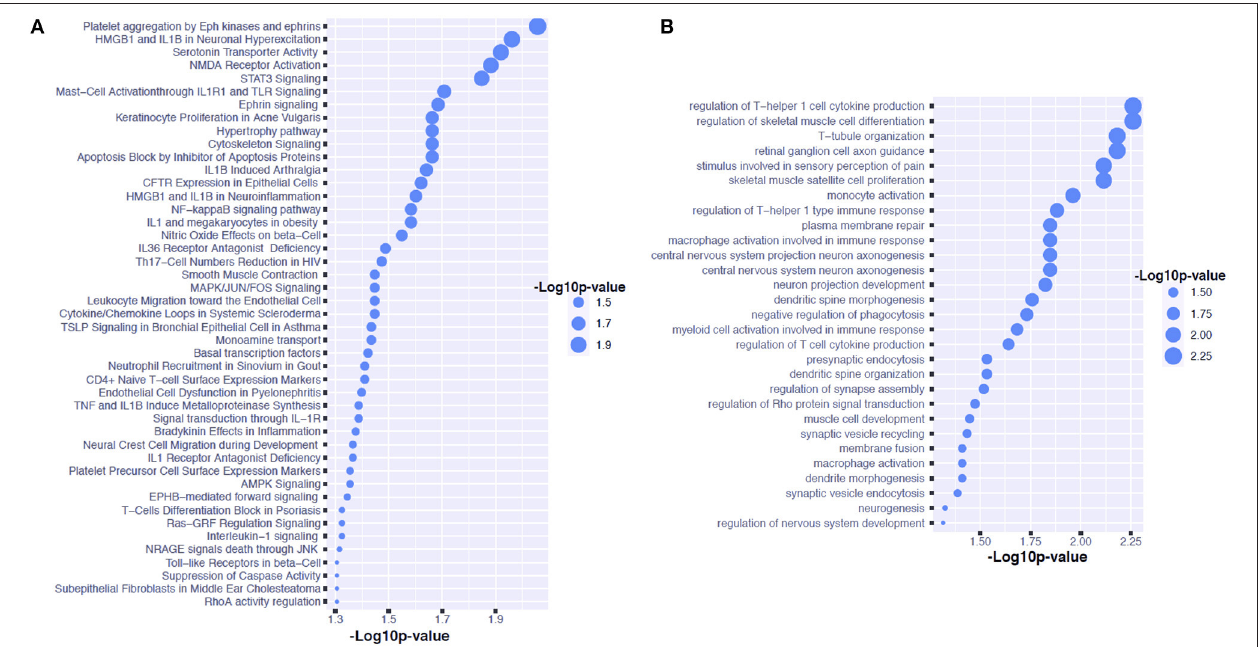
FIGURE 3 | Pathway analysis for candidate genes associated with sleep quality in children on the autism spectrum. (A) Shows the GO pathways over-represented by the genes associated with the CSHQ score. (B) Shows the signaling pathways over-represented by the genes associated with the CSHQ